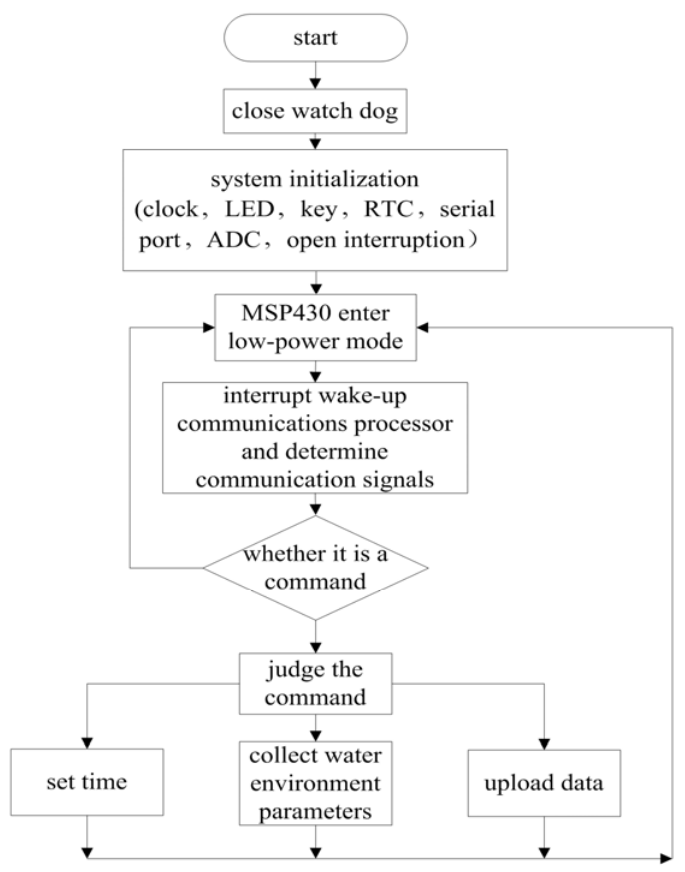
Figure 7. The flow diagram of the master